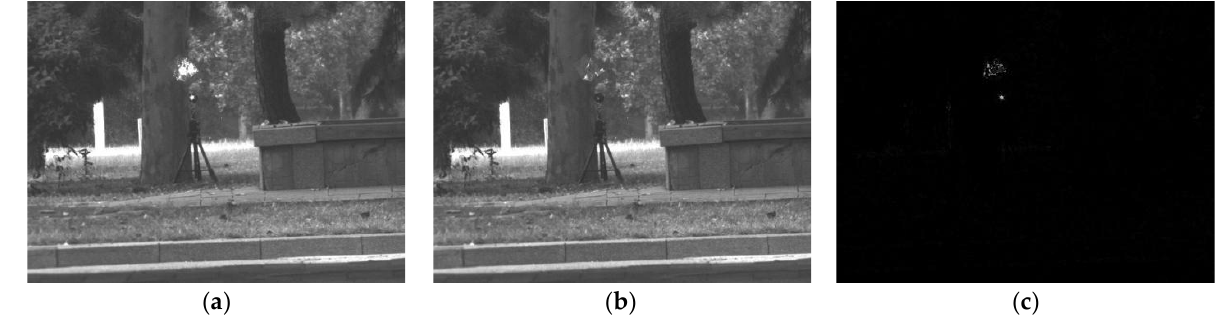
Figure 4. Image differentiation. ( a ) Active image, ( b ) passive image, and ( c ) differential image. The photoelectric target irradiates the photoelectric device with an active light source, and due to the principle of reversibility of the optical path, the incident light returns along the original optical path at the focal plane within the photoelectric device. This property of the optoelectronic devices is also known as the “cat’s eye effect”. As illustrated in Figure 4a, other spurious targets are also detected when the camera is detected. In that case, the echo power of the photoelectric target and the diffuse reflection is theoretically analyzed. The echo spot area received by the detector can be expressed